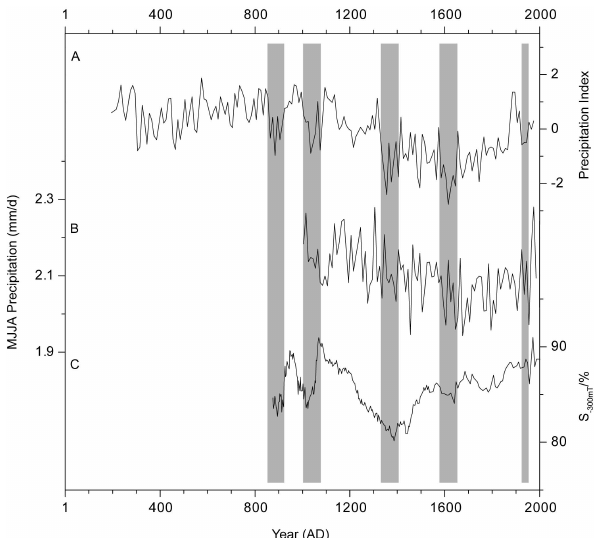
Fig. 4. Comparison of the synthesized precipitation record (A) with the coupled ECHO-G simulated precipitation record after 10-year averaged (B) – Liu et al., 2011 – and the precipitation record recon- structed from the lake sediment in Gonghai lake, Shanxi province, north central China (C) , Liu et al., 2011.